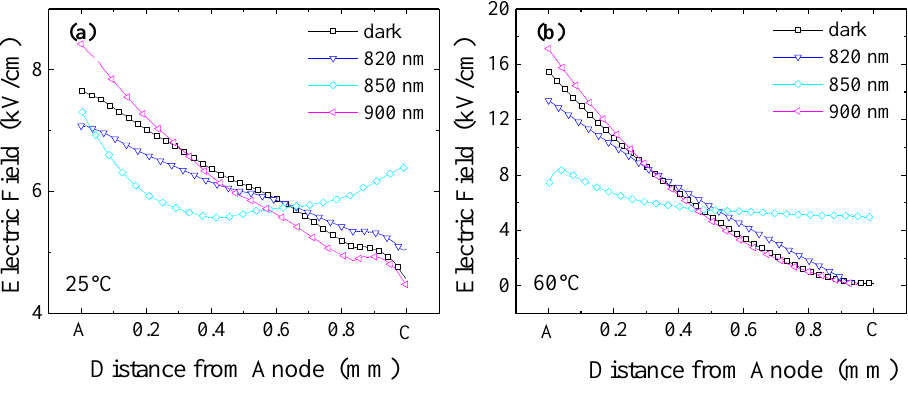
Figure 3. Electric field profiles at T = 25 °C ( a ) and T = 60 °C ( b ) under optical irradiation on the anode side: 820 nm, 850 nm, 900 nm. For comparison, the profile corresponding to no optical irradiation (dark) is also reported. Bias is 600